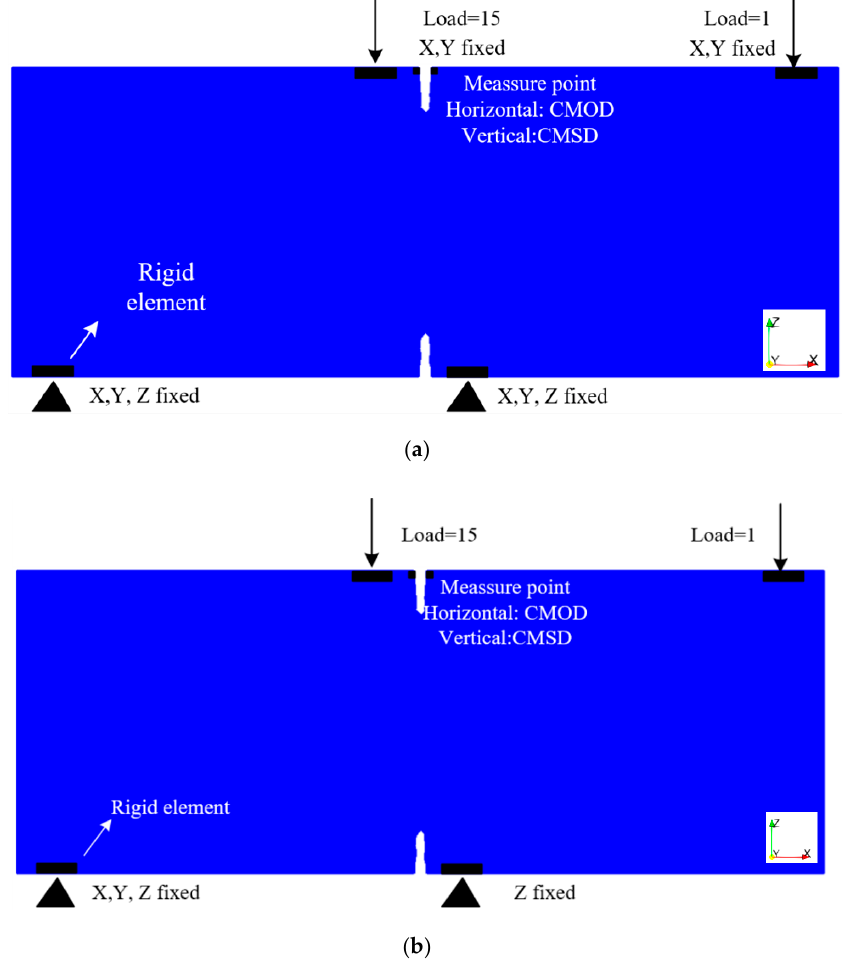
Figure 11. Setup for DEN (double-edge-notch) beam shear test ( a ) fixed supports, ( b ) freely rotating.